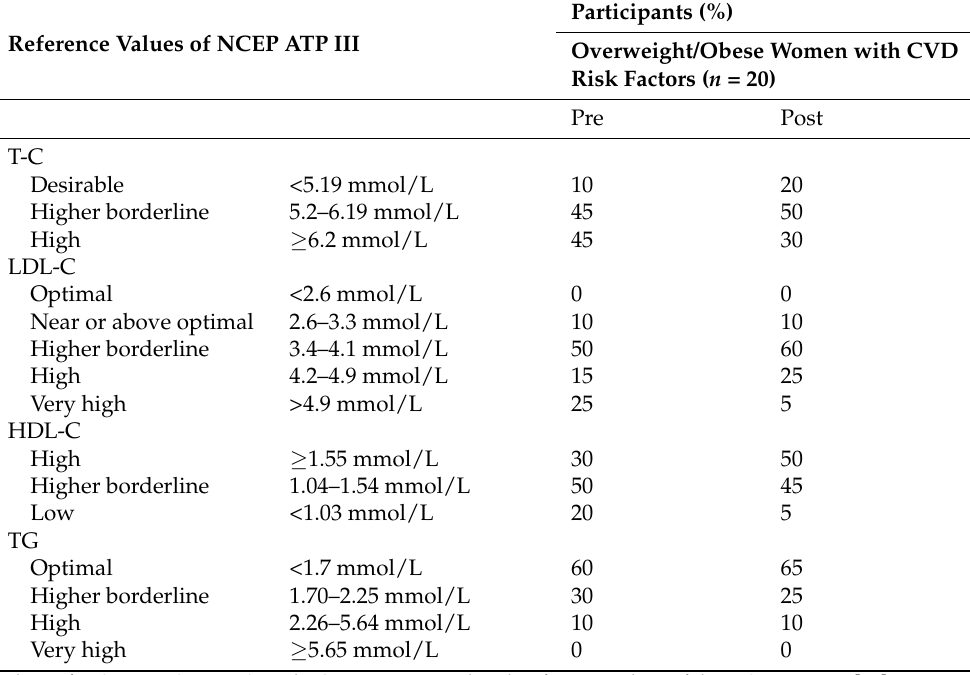
Table 4. Distribution percentage changes (%) of lipid profiles in participants pre- and post- intervention of apple/berry juice according to reference values of NCEP ATP III.